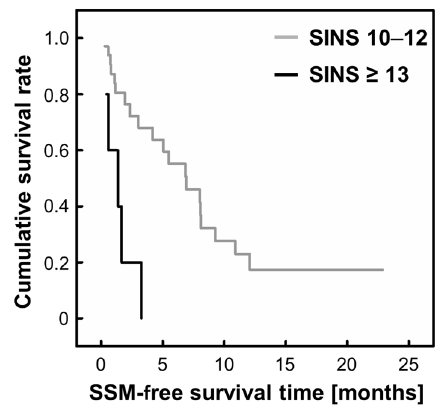
Figure 5. Kaplan–Meier SSM-free survival time curve according to the SINS ( ≥ 13 and 10–12). SINS: Spinal Instability Neoplastic Score; SSM: symptomatic spinal metastasis. n (SINS 10–12) = 35, n (SINS ≥ 13) = 5.